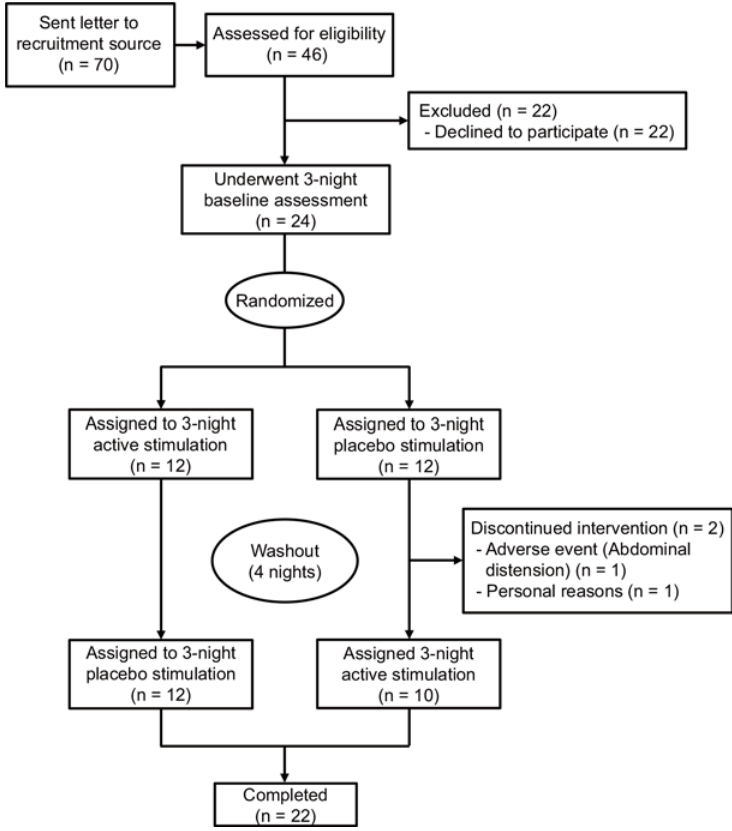
Fig 1. CONSORT flow chart. The flow chart illustrates the basic layout of the clinical trial including steps involved in recruitment of study participants and the actual steps in the clinical trial.